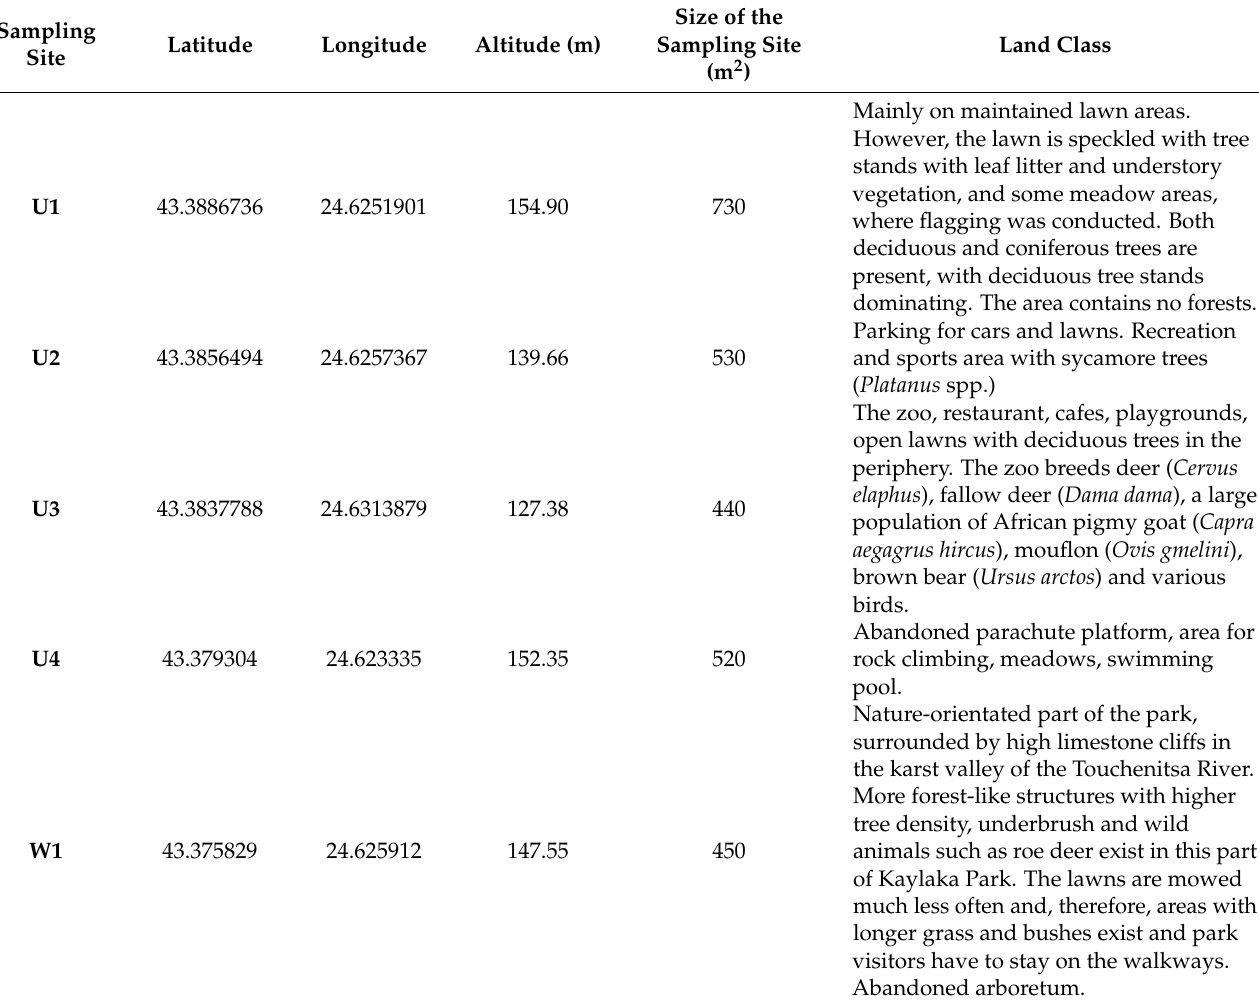
Table 1. Geographical coordinates and a brief description of the land class.